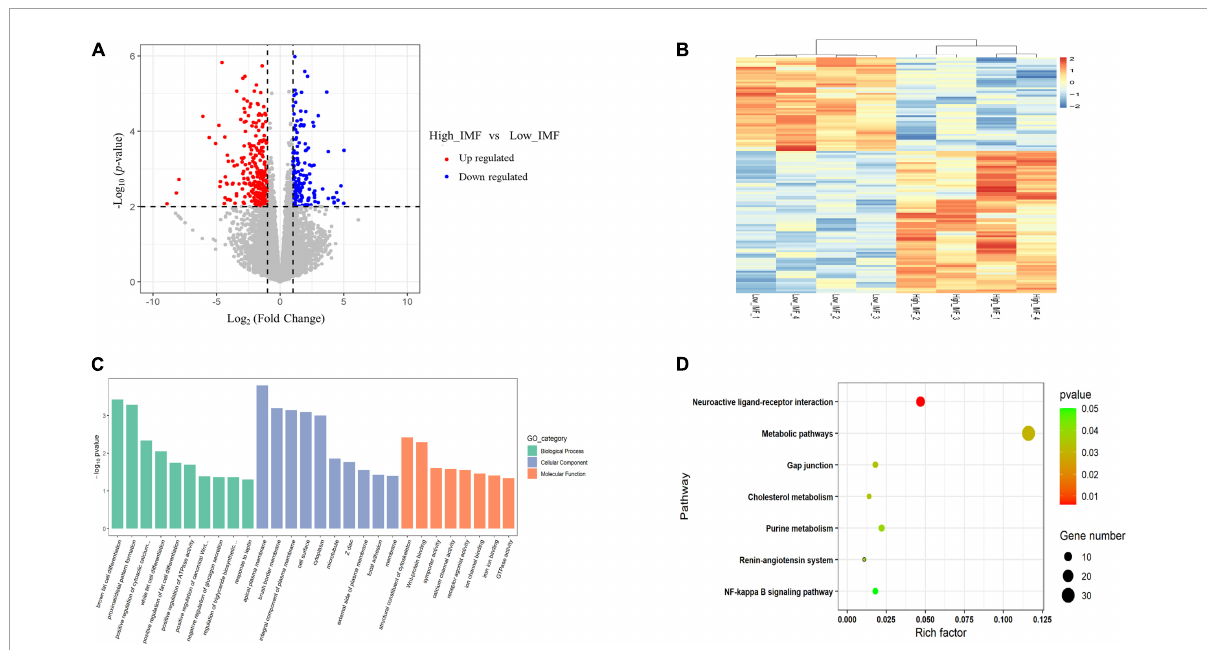
FIGURE3 Analyses of RNA-seq. (A) Scatter plot of the transcriptome data [ p < 0.05, | log2(fold change)| ≥ 1]. (B) Heatmap of the differentially expressed genes. (C) GO enrichment analysis of differentially expressed genes. (D) Bubble chart of Kyoto Encyclopedia of Genes and Genomes (KEGG) pathway enrichment analysis of differentially expressed